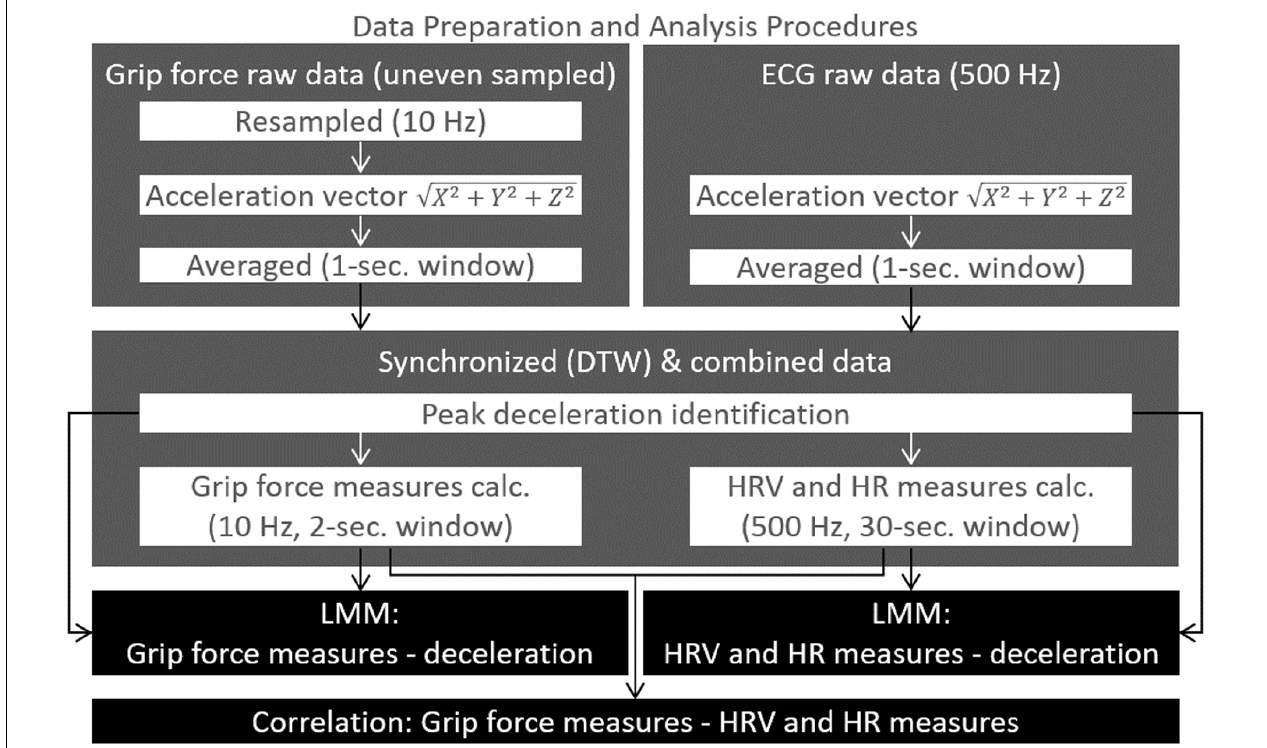
FIGURE 5 | Data preparation and analysis procedures: a workflow description of the data preparation procedures, data synchronization procedure, and the data analyses used.